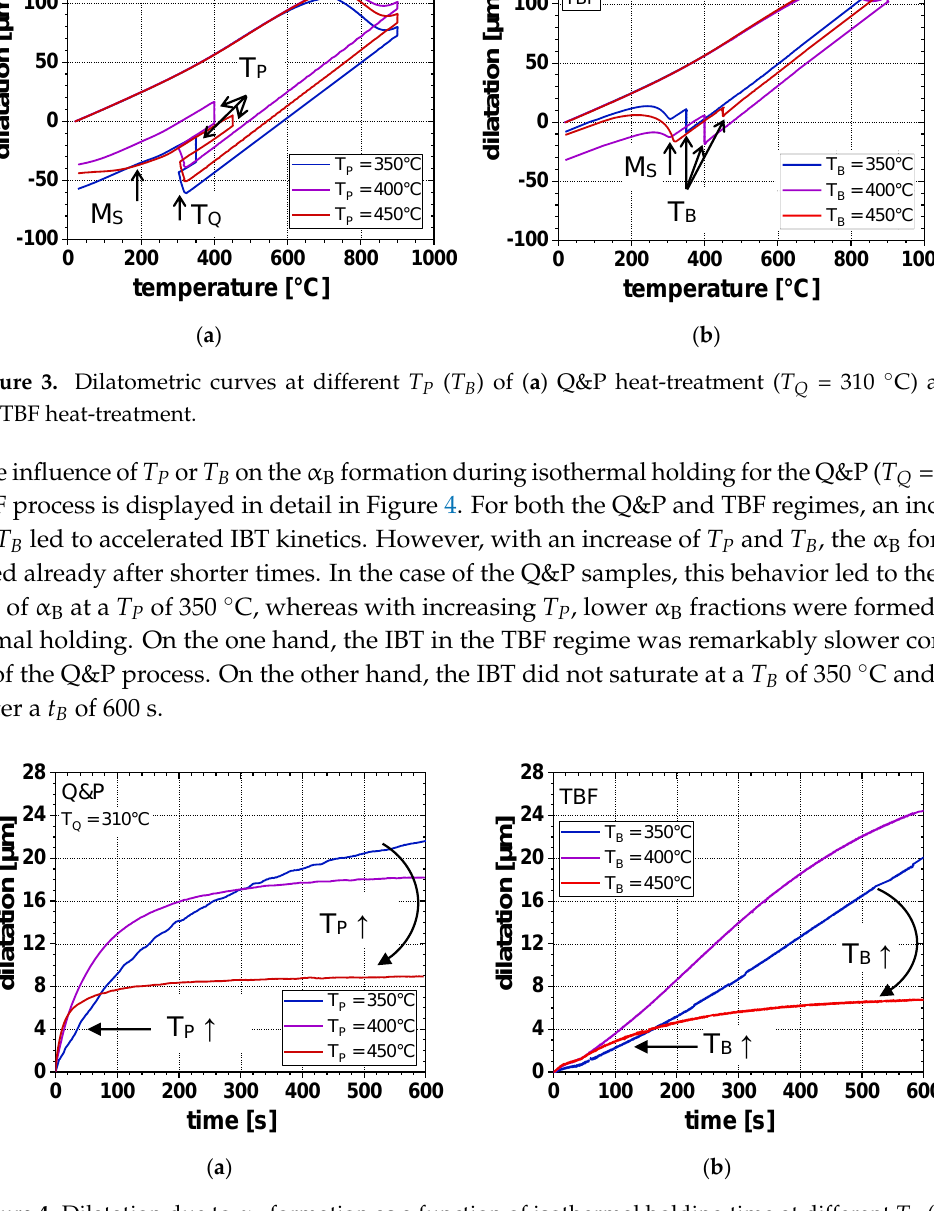
Figure 4. Dilatation due to α B formation as a function of isothermal holding time at different T P ( T B ) for ( a ) Q&P steel ( T Q = 310 °C) and ( b ) TBF steel.